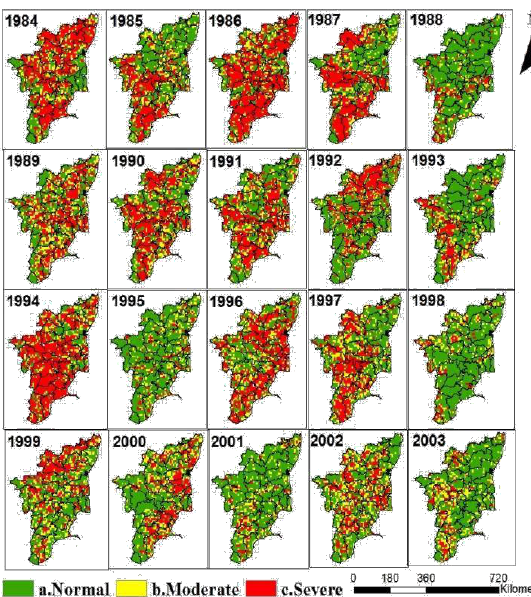
Figure 8 Drought intensity maps for 20 years during